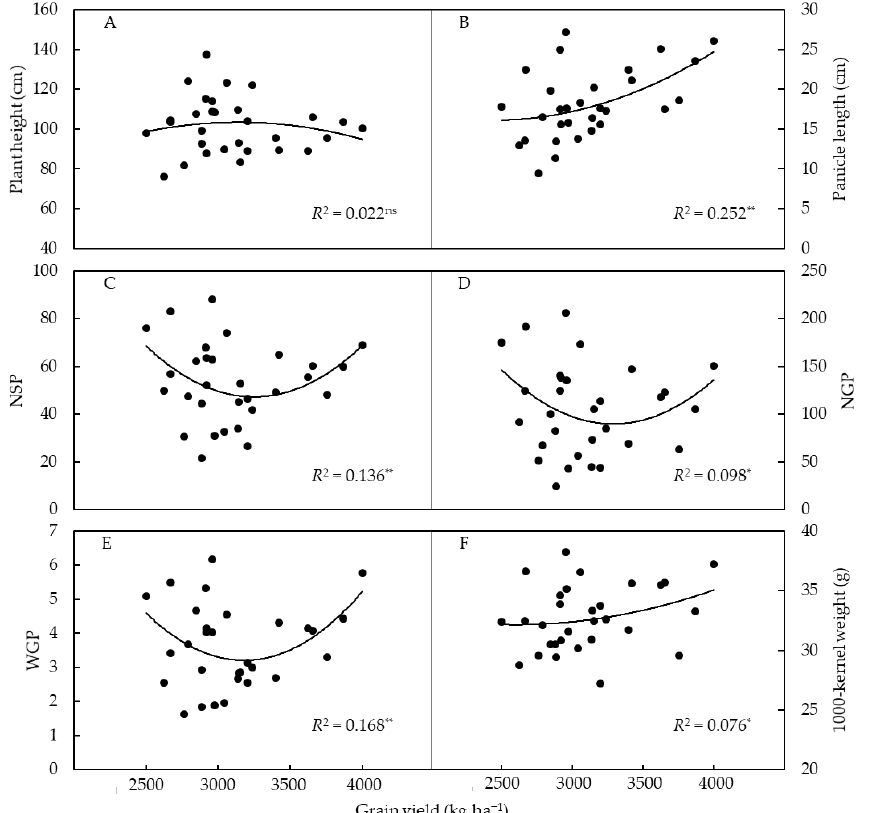
Figure 2. Relationships of grain yield with the plant height, panicle length, number of spikelets per panicle (NSP), number of grains per panicle (NGP), weight of grains per panicle (WGP), and 1000-kernel weight of oat. Lines describe quadratic regression equations (y = a + bx − cx 2 ); ns, not significant; * and ** significant at p < 0.05 and p < 0.01, respectively. Table 4. Regression of net photosynthetic rate (Pn), stomatal conductance (Gs), intercellular CO 2 concentration (Ci), transpiration rate (Tr), water-use efficiency (WUE), stomatal limitation value (Ls), leaf area index (LAI), grain yield, plant height, panicle length, number of spikelets per panicle (NSP), number of grains per panicle (NGP), weight of grains per panicle (WGP), and 1000-kernel weight of oat on nitrogen fertilizer or planting density; * and ** significant at p < 0.05 and p < 0.01, respectively. Nitrogen Fertilizer (x 1 ) Planting Density (x 2